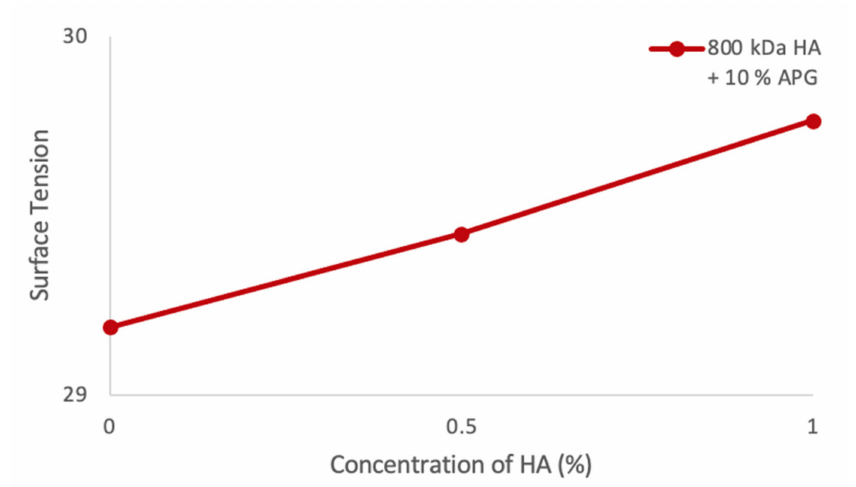
Figure 9. Effect of HA concentration and APG on surface